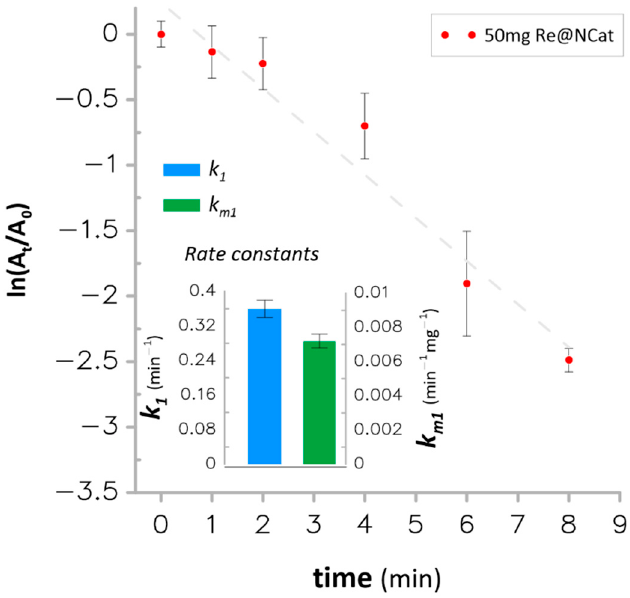
Figure 6. The first-order kinetics plot for catalytic hydrogenation of 4-NA using 50 mg of the Re@NCat.